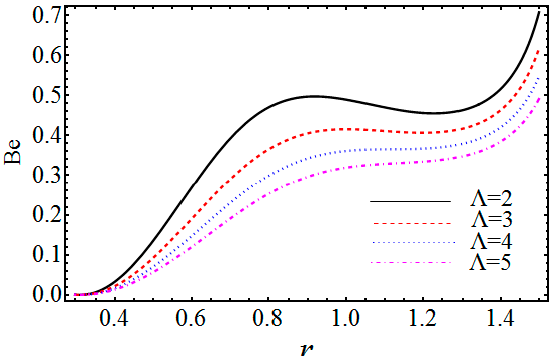
Figure 22. Curves of 𝐵𝑒 with fixed Λ where 𝜃 = 0.1, 𝜑 = 0.5,𝛿 = 0.1, 𝜀 = 0.2, 𝑉 = 0.3, 𝜆 (cid:2869) = 0.1, 0, t = 0.1, Gc = 0.01, Γ = 0.4, Nt = 0.5, Br = 1, Gr = 5, Ω = 0.3, Nb = 0.9, Q = 𝑧 = 0,𝑡 = 0.1,𝐺𝑐 = 0.01, Γ = 0.4,𝑁𝑡 = 0.5, 𝐵𝑟 = 1, 𝐺𝑟 = 5,Ω = 0.3,𝑁𝑏 = 0.9,𝑄 = 1.